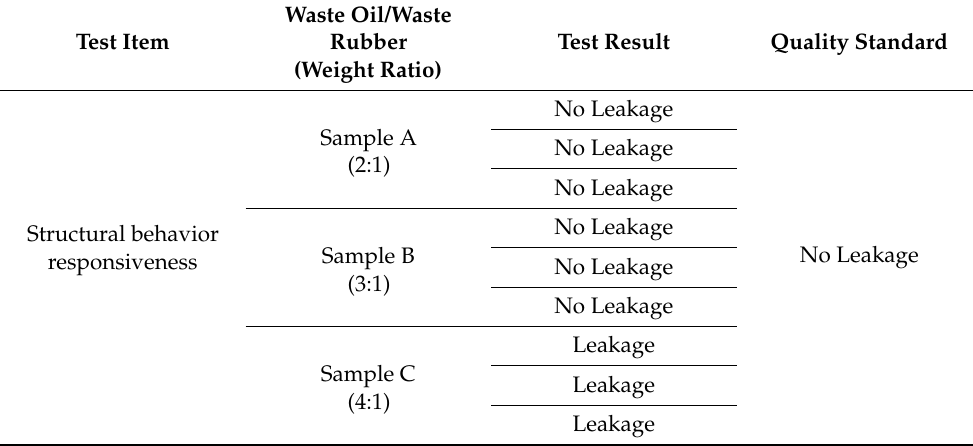
Table 6. Structural behavior responsiveness by sample of W-SPRG.